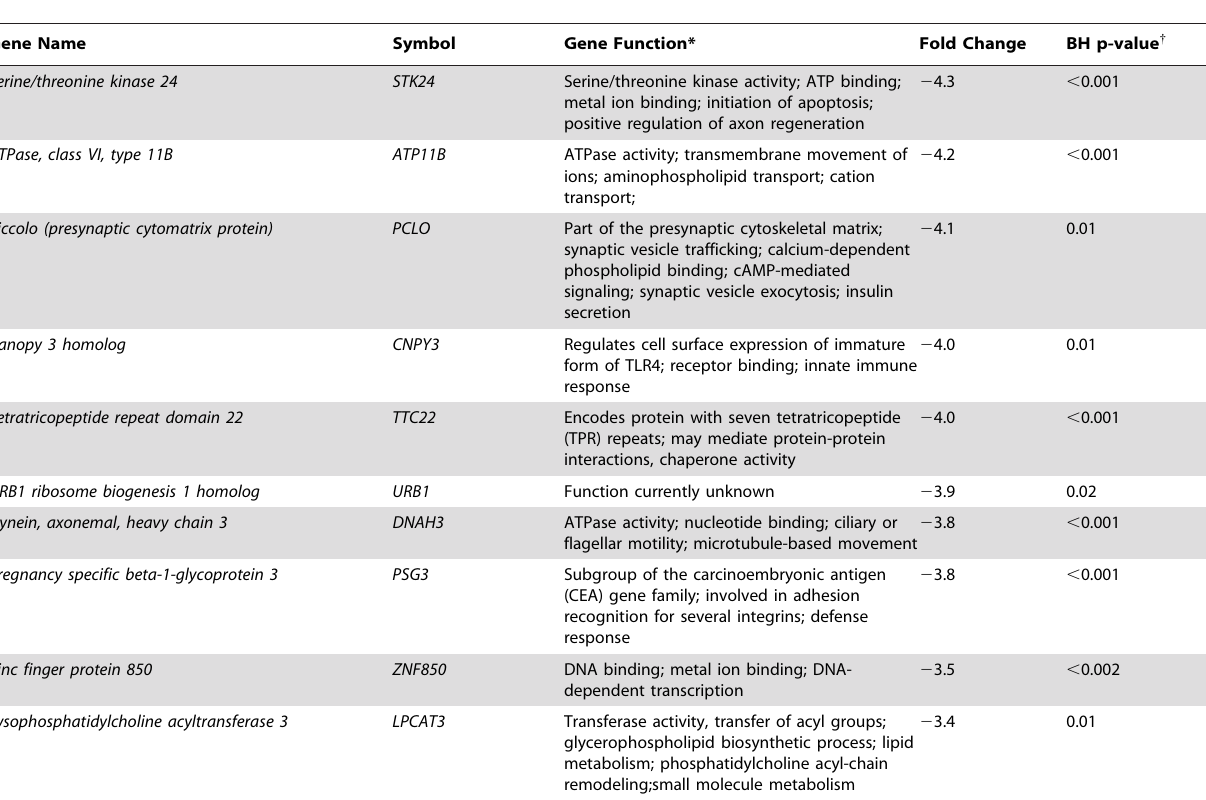
Table 4. Top ten most down-regulated genes in fetuses of obese versus lean women in the second trimester.